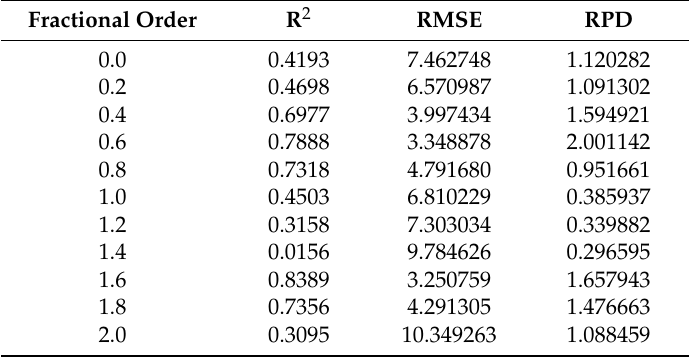
Table 3. Accuracy evaluation for the SMLR prediction